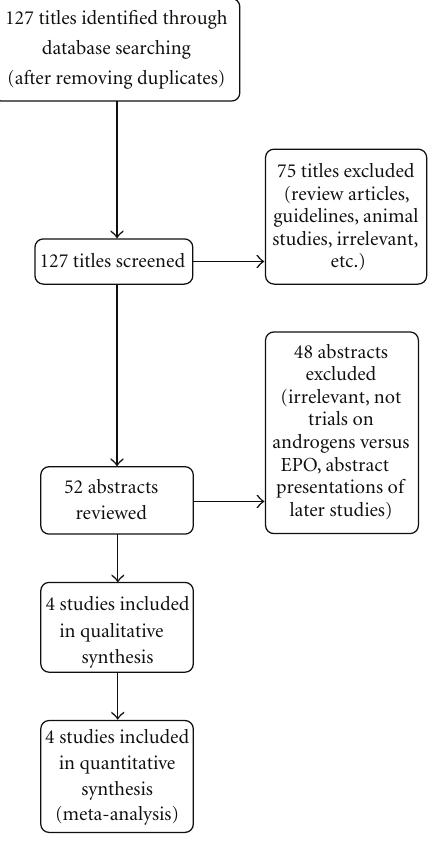
two arms of treatment (e.g., androgen versus EPO versus androgen plus EPO), we extracted data for only androgens and the EPO